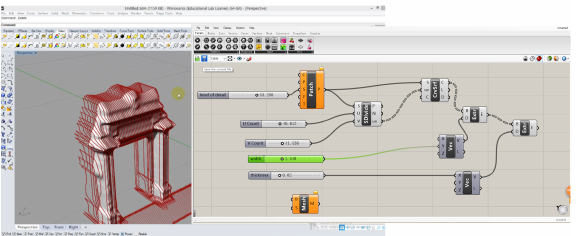
Figure 12. Extracting the profiles of captured data by generative tool